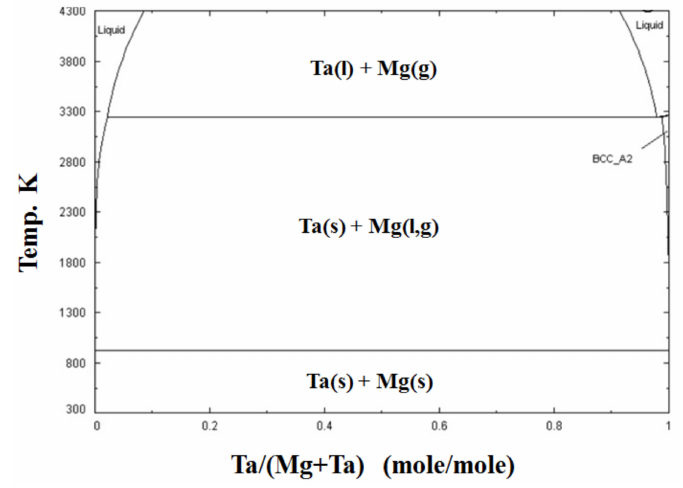
Figure 4. Ta–Mg phase